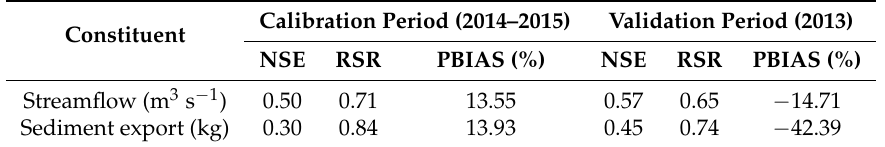
Table 4. The calibration (2014–2015) and validation (2013) results of the baseline scenario by the Spatially Explicit Integrated Modeling System (SEIMS)-based watershed model. (NSE = Nash–Sutcliffe Efficiency, RSR = Root mean Square error–standard deviation Ratio, PBIAS = Percent